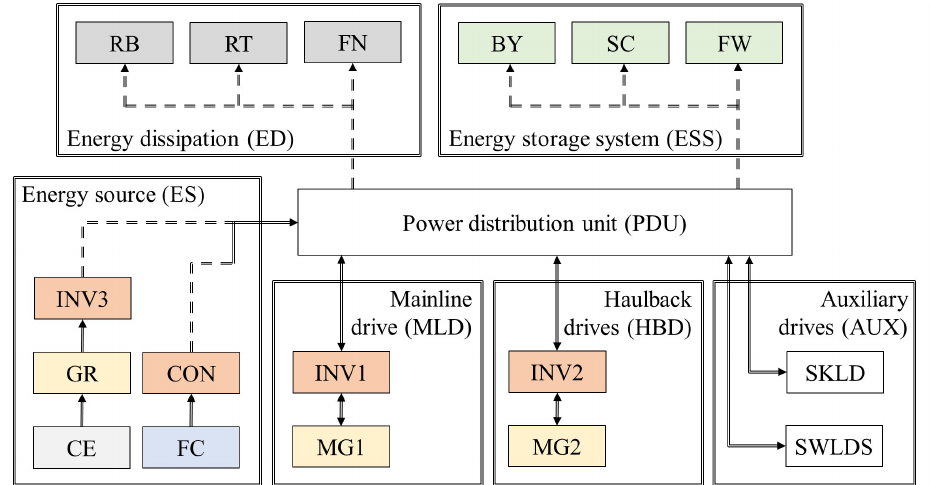
Figure 6. Key subsystem options and building blocks of a hybrid TY